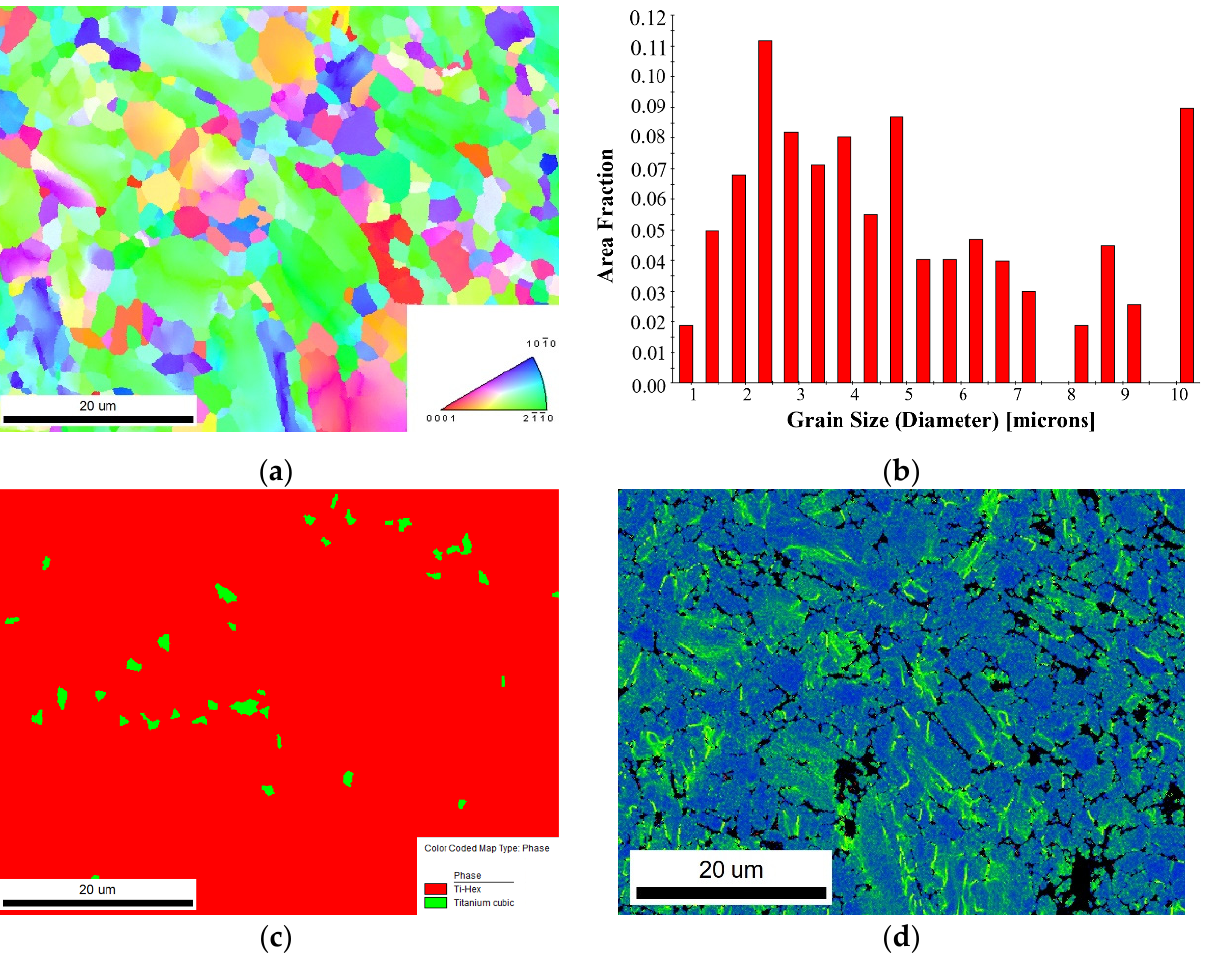
Figure 5. Microstructure maps of the Ti-6Al-4V surface before milling. ( a ) The grain orientation distribution map. ( b ) The grain size statistic map. ( c ) The phase distribution map. ( d ) The KAM map.